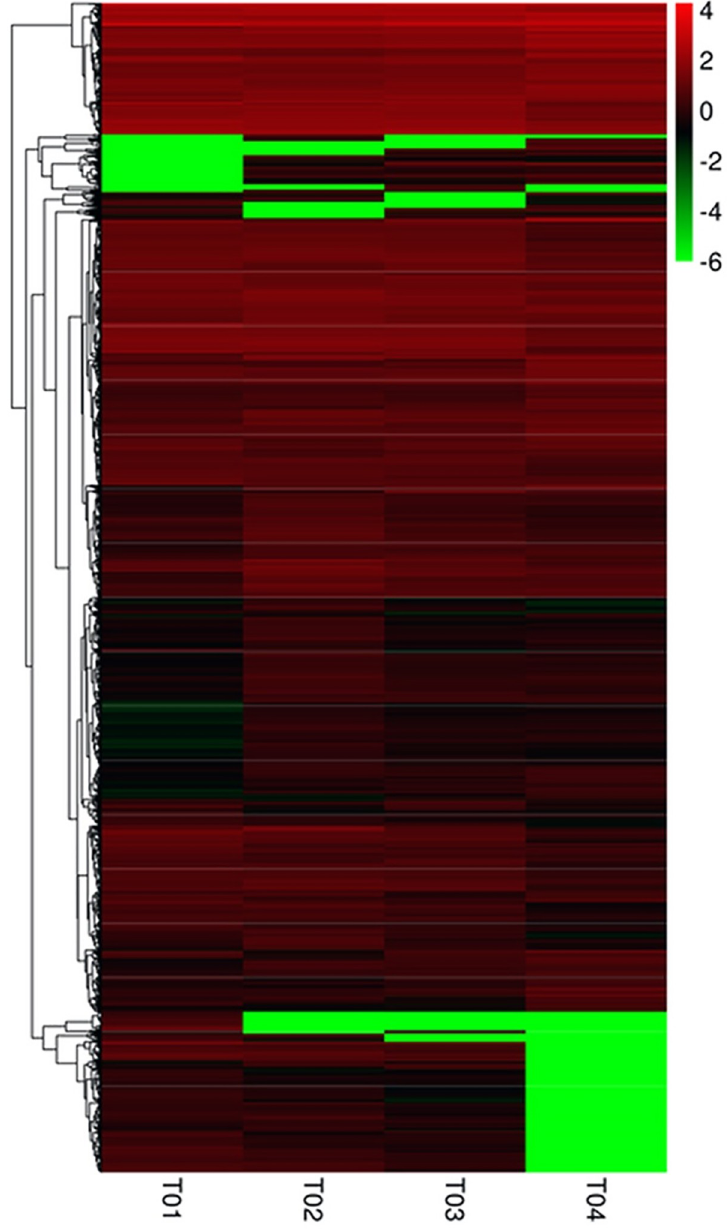
Fig 3. Differentially expressed genes cluster. Columns represent different samples; rows are different genes. The green color indicates the down-regulated and red indicates the up-regulated expression of genes. T01: Stress treatment 0 h, T02: Stress treatment 24 h, T03: Stress treatment 48 h, T04: Stress treatment 96 h.